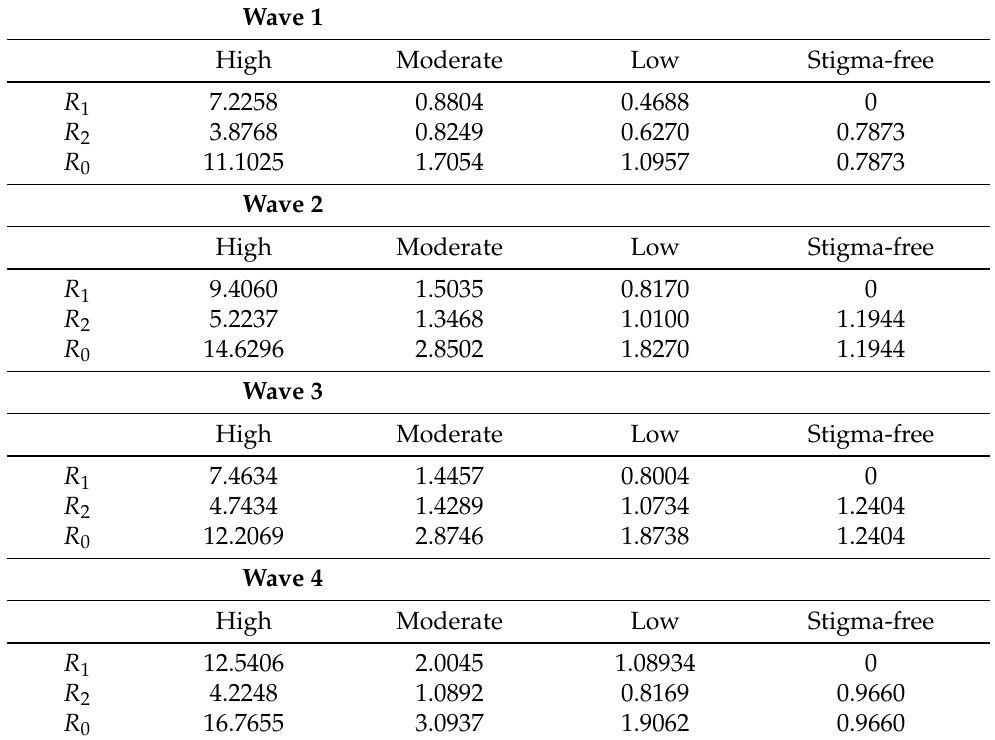
Figure 9. Comparison between cumulative stigmatised populations. ( a ) High stigma cumula- tive cases. ( b ) Moderate stigma cumulative cases. ( c ) Low stigma cumulative cases. Table 4. The estimated basic reproduction number for COVID-19 waves in South